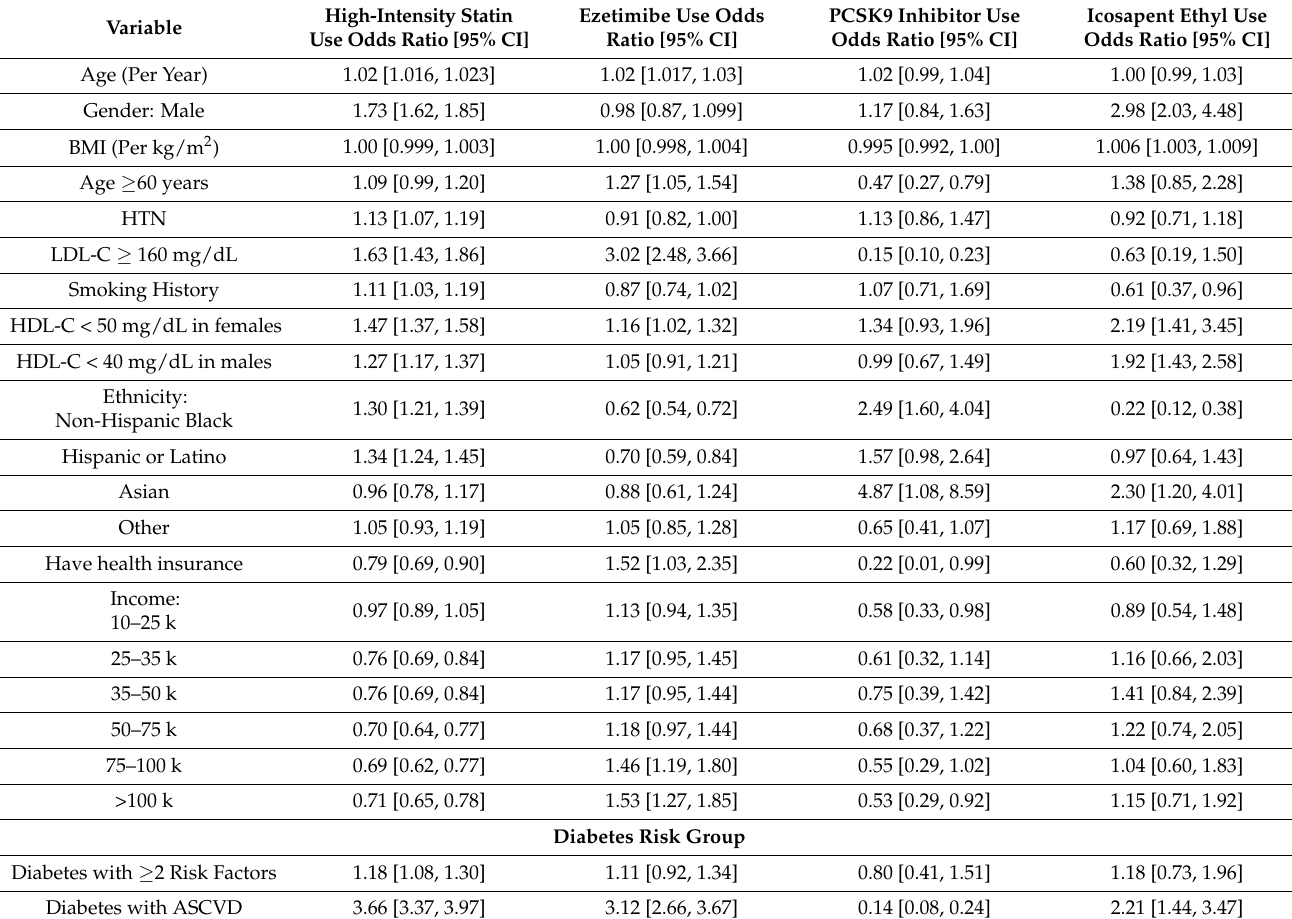
Table 4. Multiple logistic regression of indicators for high-intensity statin, ezetimibe, PCSK9 inhibitor, and icosapent